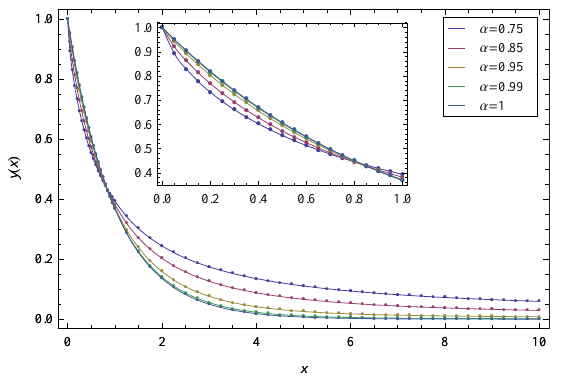
Fig. 4: Comparison of y ( x ) for h = 1 , N = 30 and α = 1.85, 1.95, 1.99, 2 with exact solutions for Example 1. immersed in a Newtonian